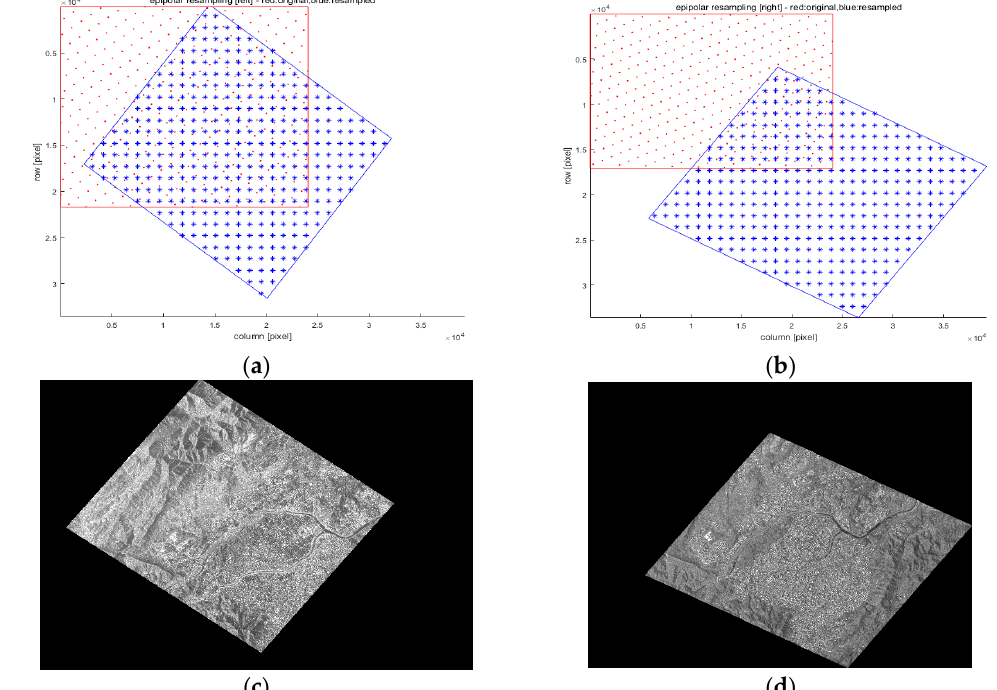
Figure 6. Epipolar image resampling of Kompsat-3A across-track stereo images: ( a , c ) K3A-4099 (red dots: original image points, blue dots: resampled image points), ( b , d ) K3A-4205.